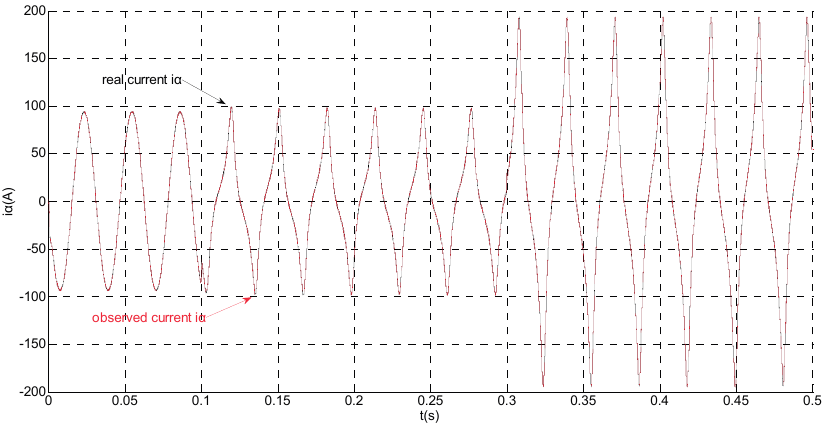
Figure 12. Simulation results of the actual and observation of α axis stator